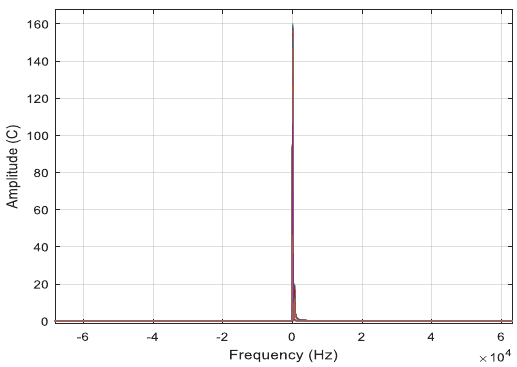
Figure 12. Fourier transformation of the collected temperature data for all the machine states.